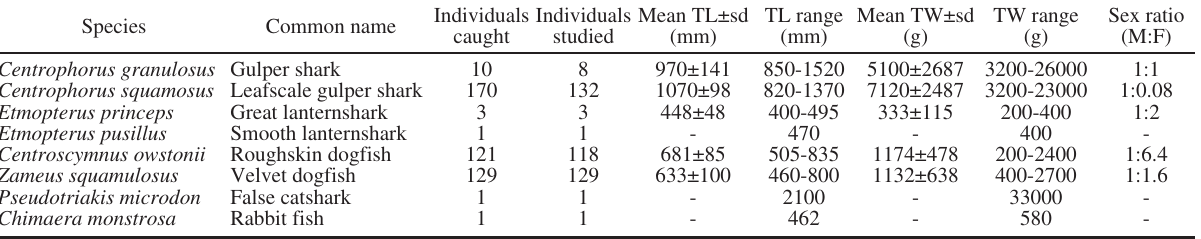
Table 1. – Chondrichthyan species caught, with number of individuals, descriptive statistics for size and weight, and sex ratio (males:females). Size as total length (TL); weight as total weight (TW). Species Common name